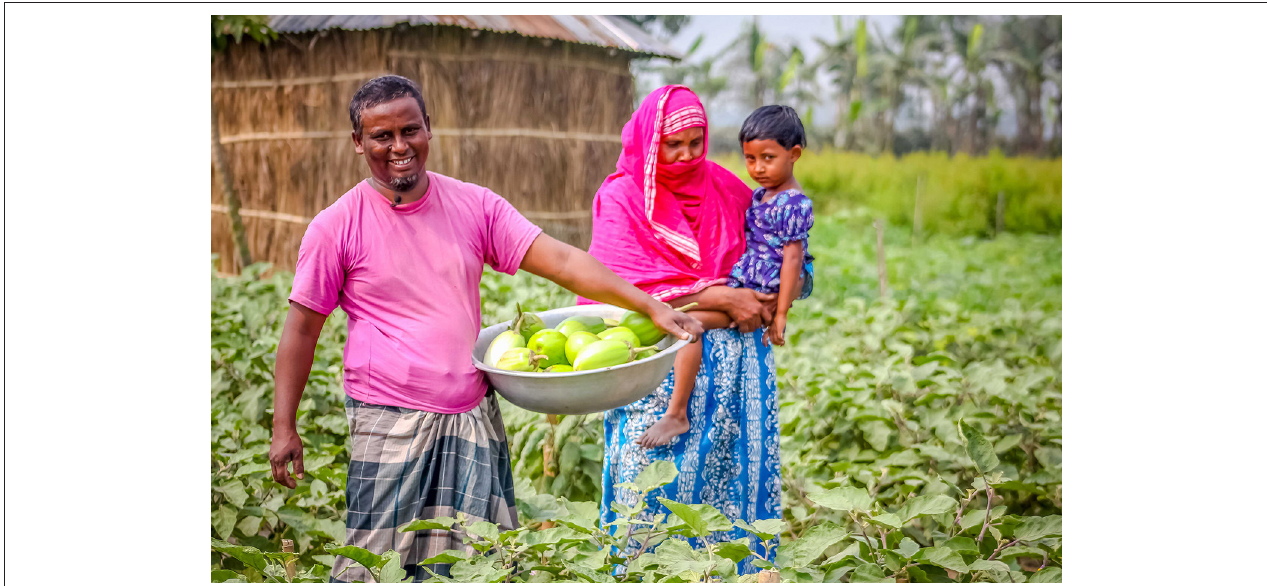
FIGURE 2 | Bangladesh farmer Md. Saiful Islam and his family harvesting Bt brinjal. Photograph by Md. Arif Hossain and used with permission of photographer and the Islam